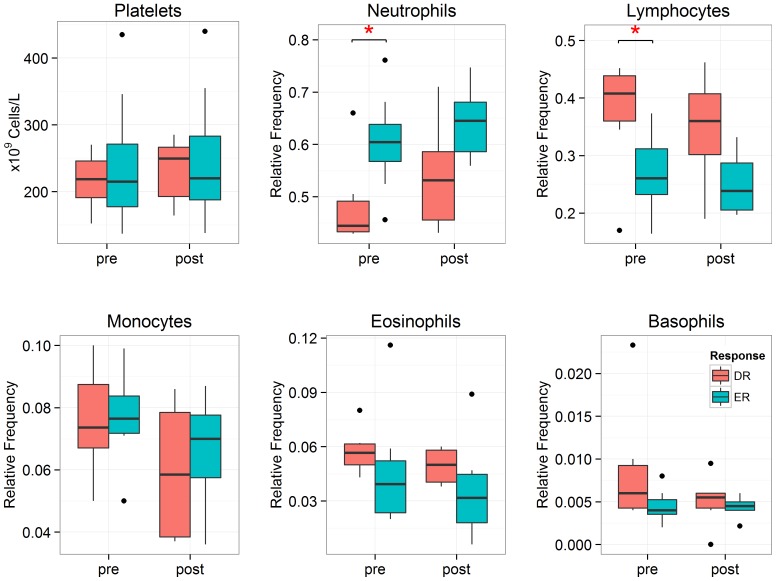
Complete blood counts.Relative frequencies of various leukocytes obtained at pre and post-challenge. The relative neutrophil counts were significantly (p = 0.01) elevated in ERs compared to DRs, whereas the relative lymphocyte counts were significantly reduced (p = 0.02) in ERs compared to DRs at pre-challenge. The p-value was computed using a robust linear model (see Methods); * denotes p<0.05.